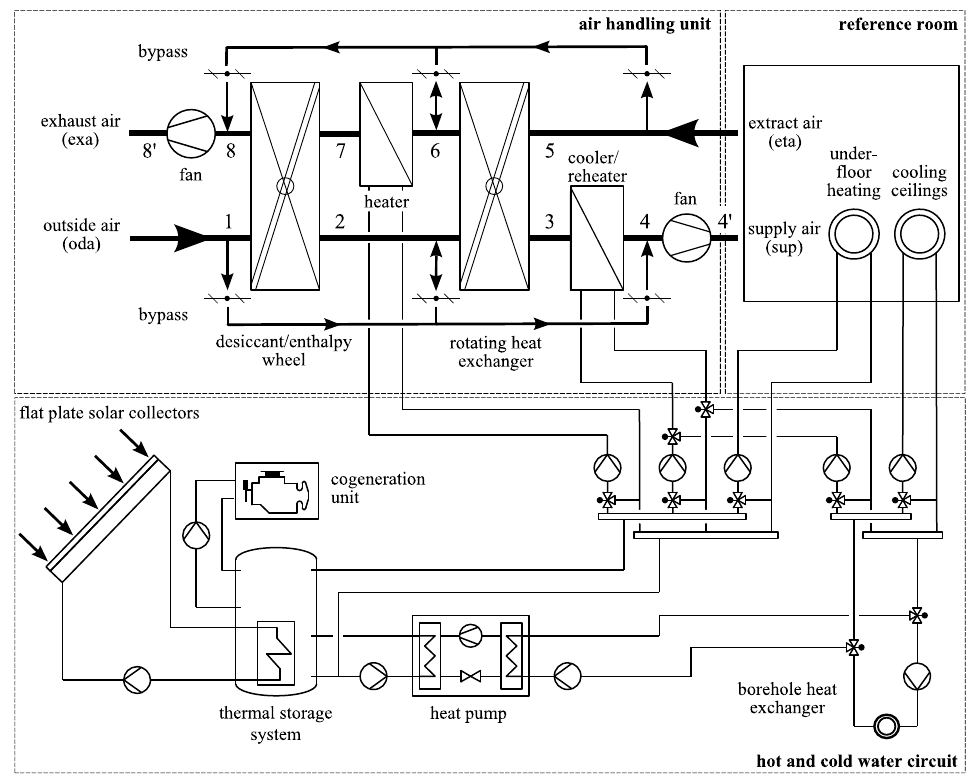
Figure 2. System layout of the test facility as used during summer and winter operation.